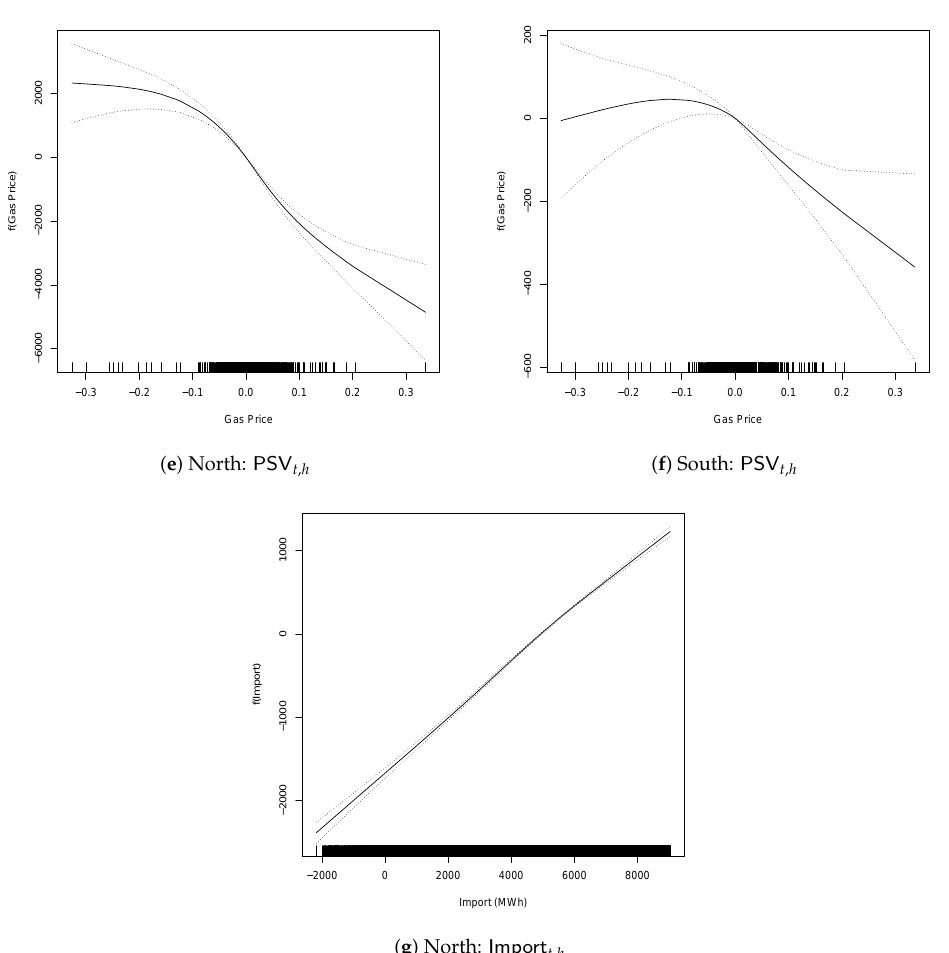
Figure 9. In-sample estimation results of the non-parametric additive model for the conditional mean of electricity demand. For both zones, each panel plots the estimated function f j ( · ) for the lagged demand ( D t − 1, h ), lagged price ( P t − 1, h ), the PSV return PSV t , h and the variable ( Import t , h ).